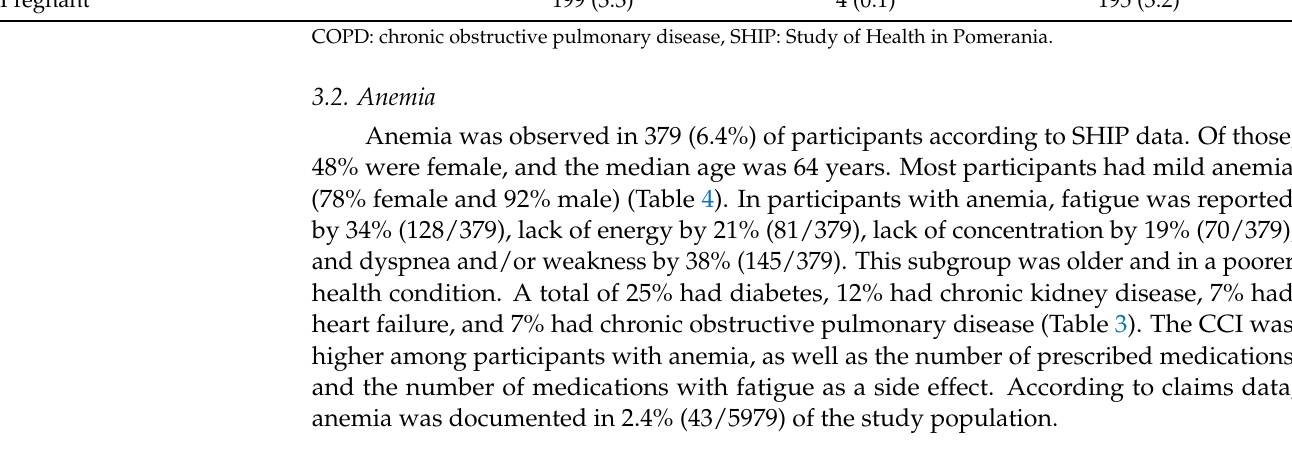
Table 4. Categorization of anemia severity in anemic study subjects according to hemoglobin normal values from the World Health Organization